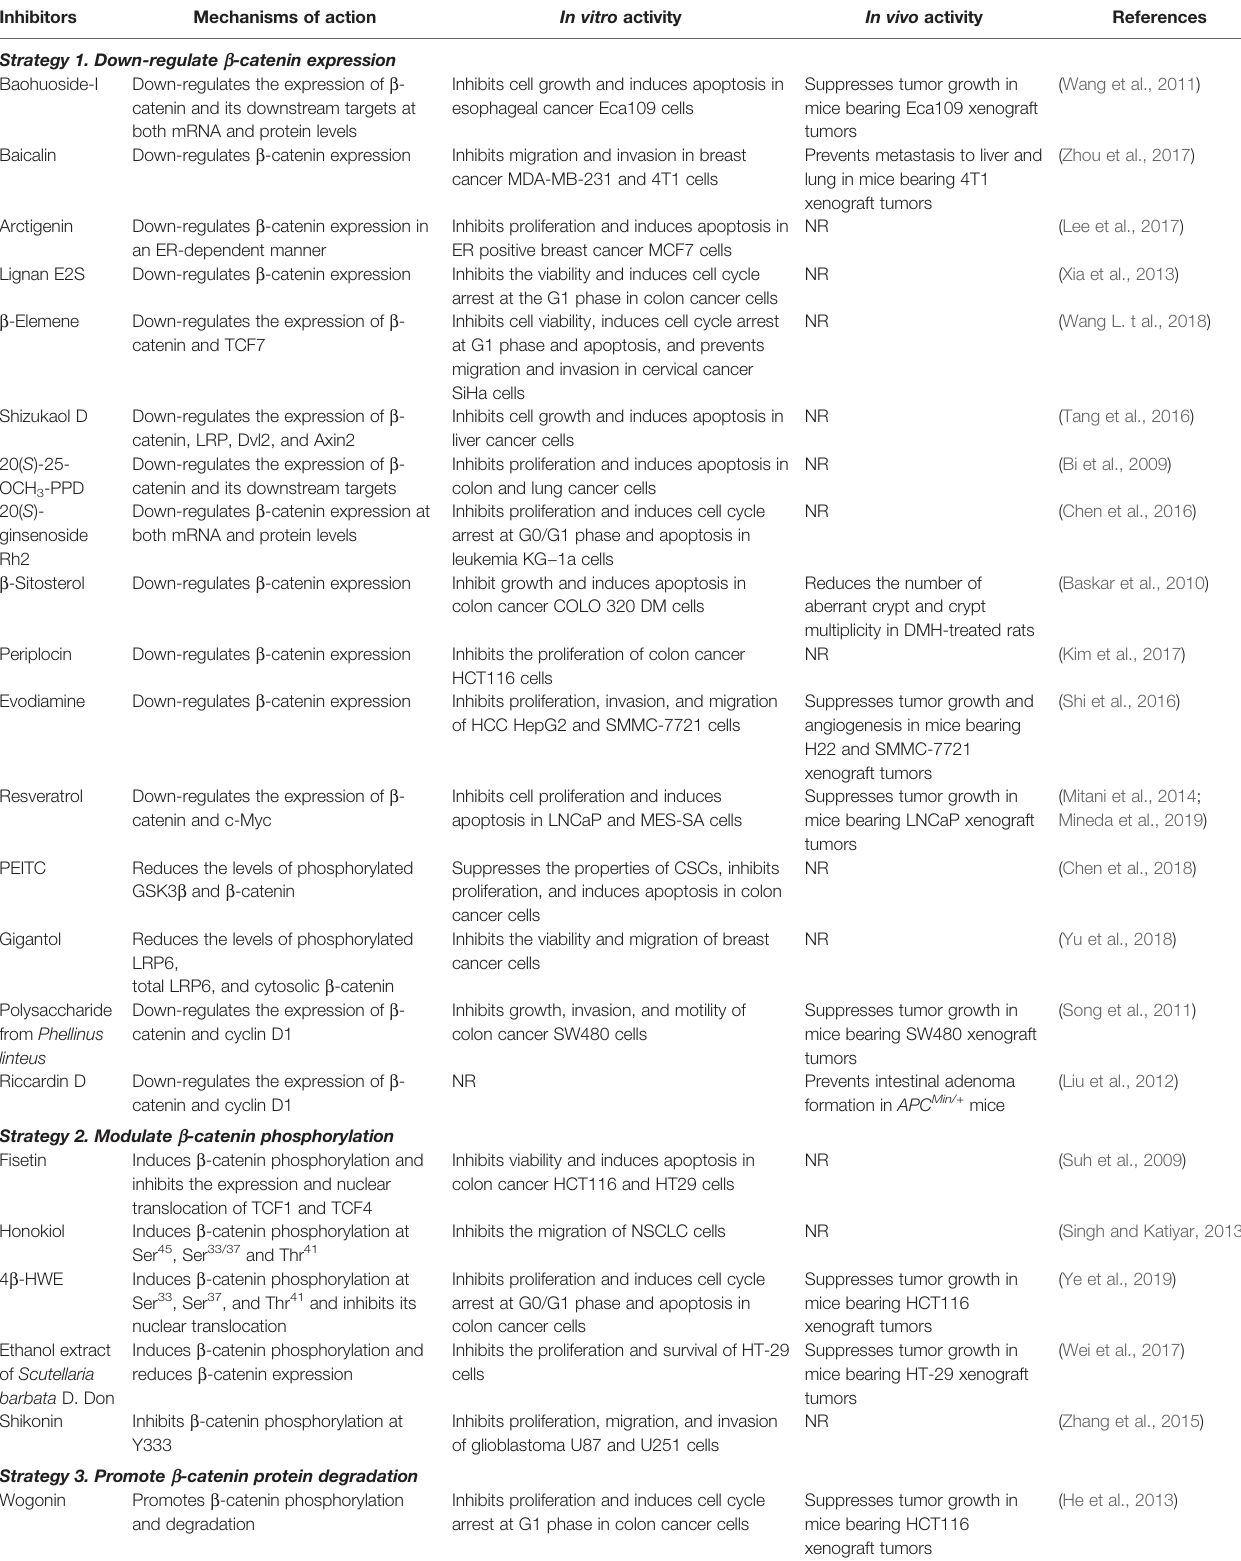
TABLE 1 | Natural product b -catenin inhibitors and their activities and mechanisms of